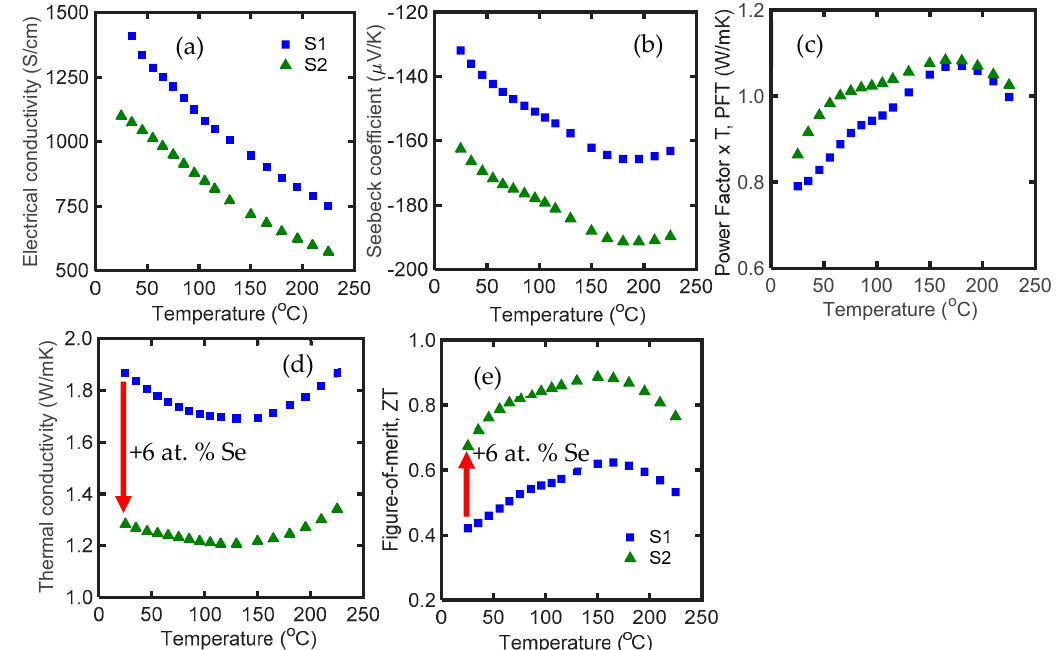
Figure 2. ( a ) Electrical conductivity; ( b ) Seebeck coefficient; ( c ) power factor × temperature; ( d ) thermal conductivity; and ( e ) zT of S1 and S2 as a function of temperature in the range of 25 °C to 225 °C. According to Table 1, S1 is a pure Bi 2 Te 3, and S2 is Bi 2 Te 3 with 6 at. % Se.